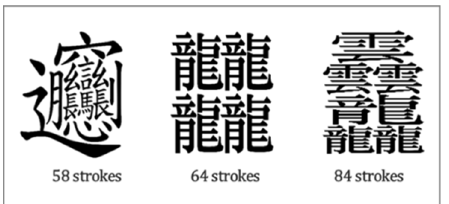
Figure 4. Examples of the complexity of Chinese characters.